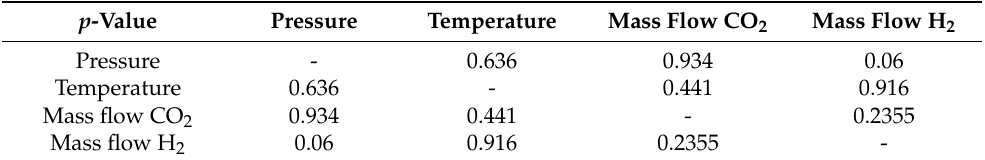
Table 5. A correlation analysis between the input variables.